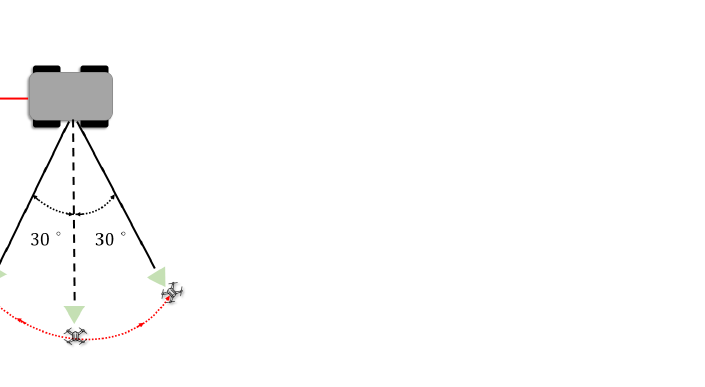
Figure 7. A UAV tracks a target at a desired relative angle that changes over time. The desired relative angle was ψ ∗ = 30sin ( t ) + 90.